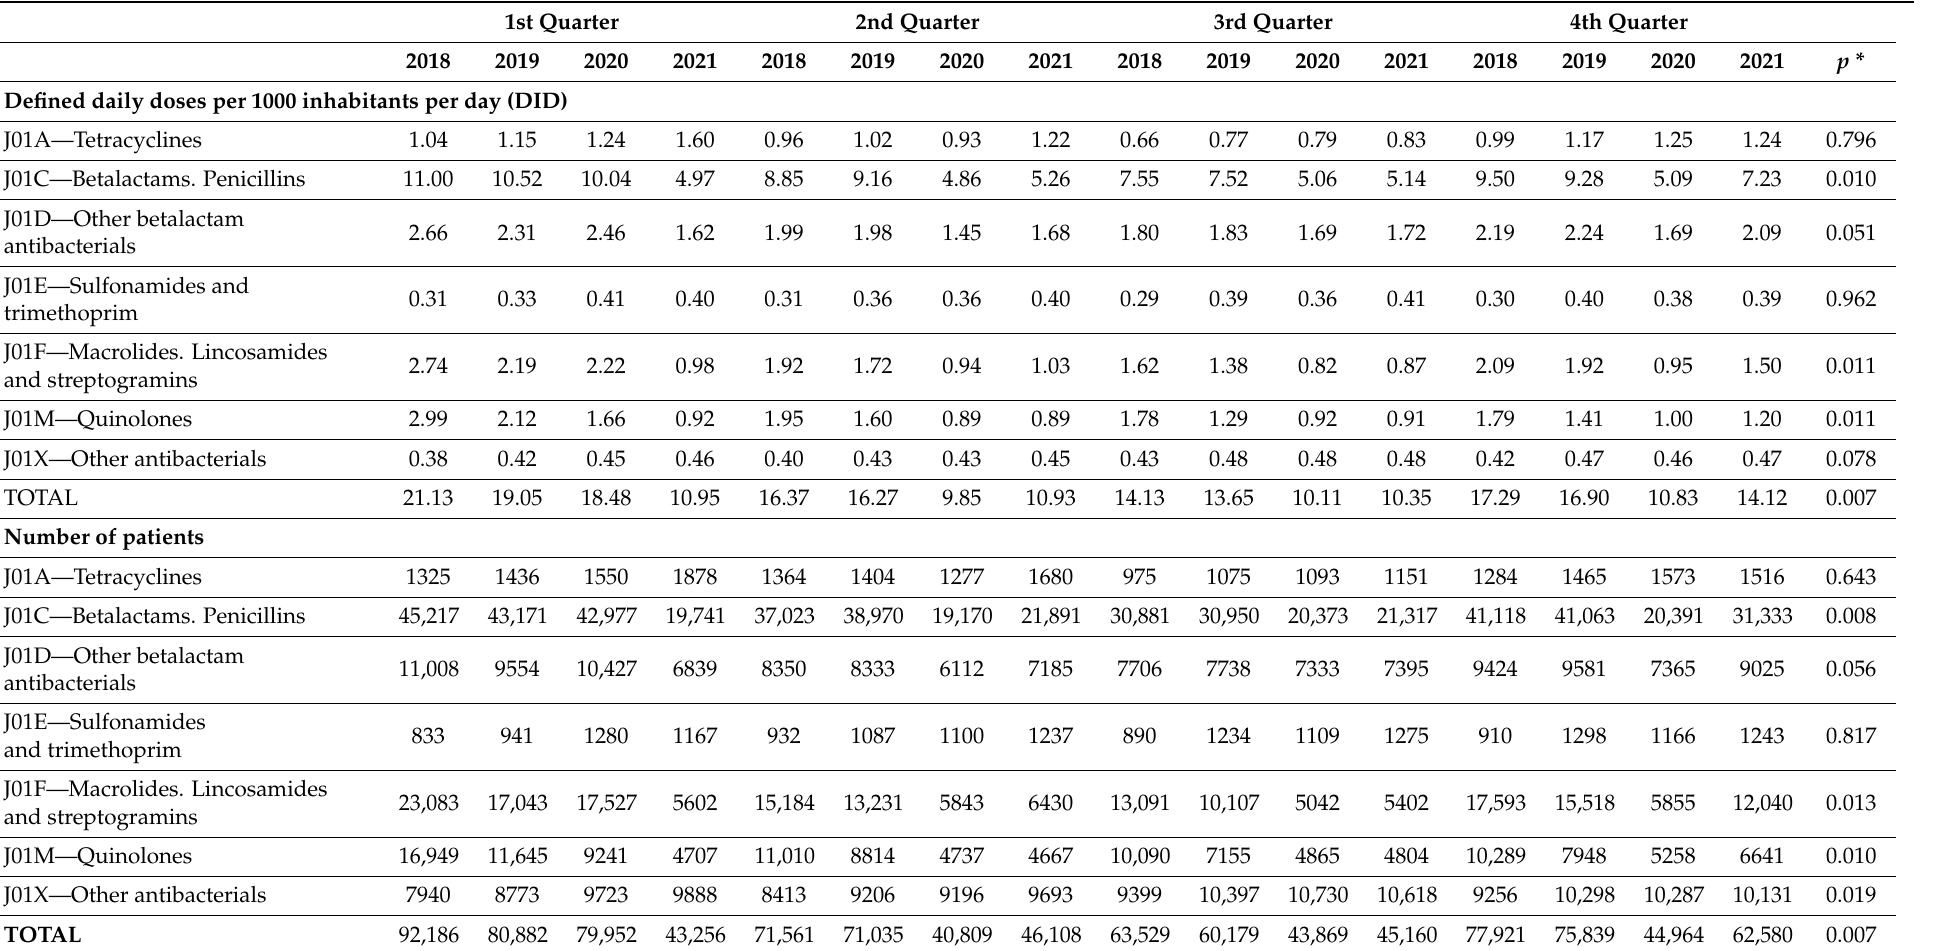
Table 1. Evolution of the consumption of antibacterials for systemic use (ATC group J01) in the community in Navarre per quarters (DID and number of